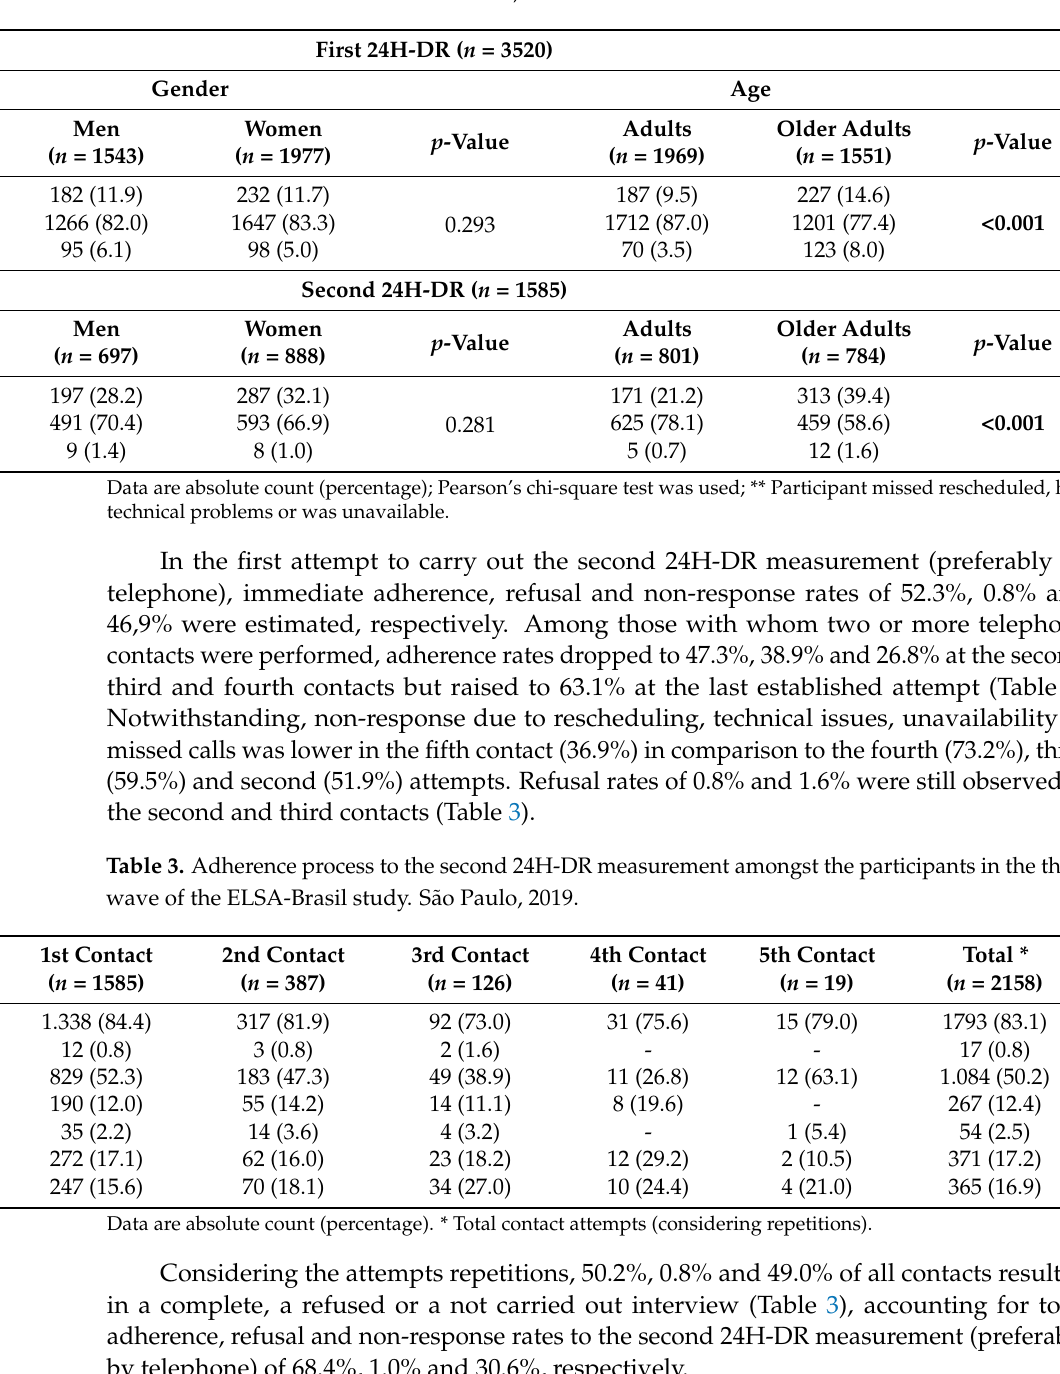
Table 2. Frequency of adherents, refusing and non-responders to the first (face-to-face) and second (preferably by telephone) 24H-DR measurements, according to gender and age of the participants in the third wave of ELSA-Brasil. S ã o Paulo, 2019.